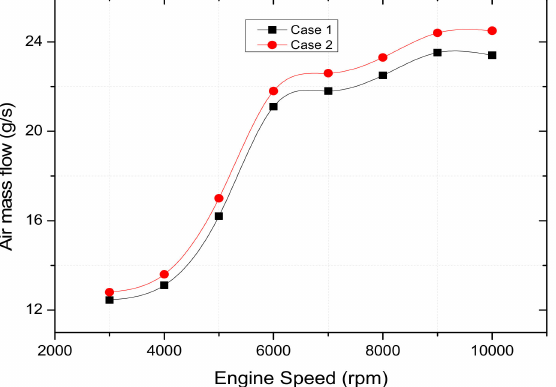
Figure 7. Effect flow chart.